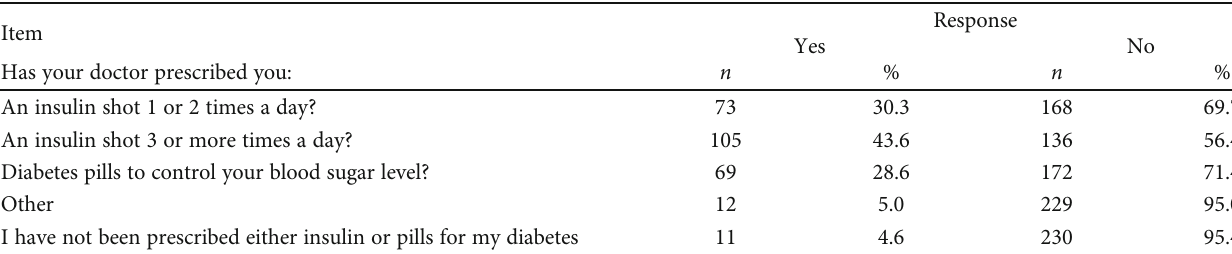
Table 6: Responses to the extended SDSCA survey medication